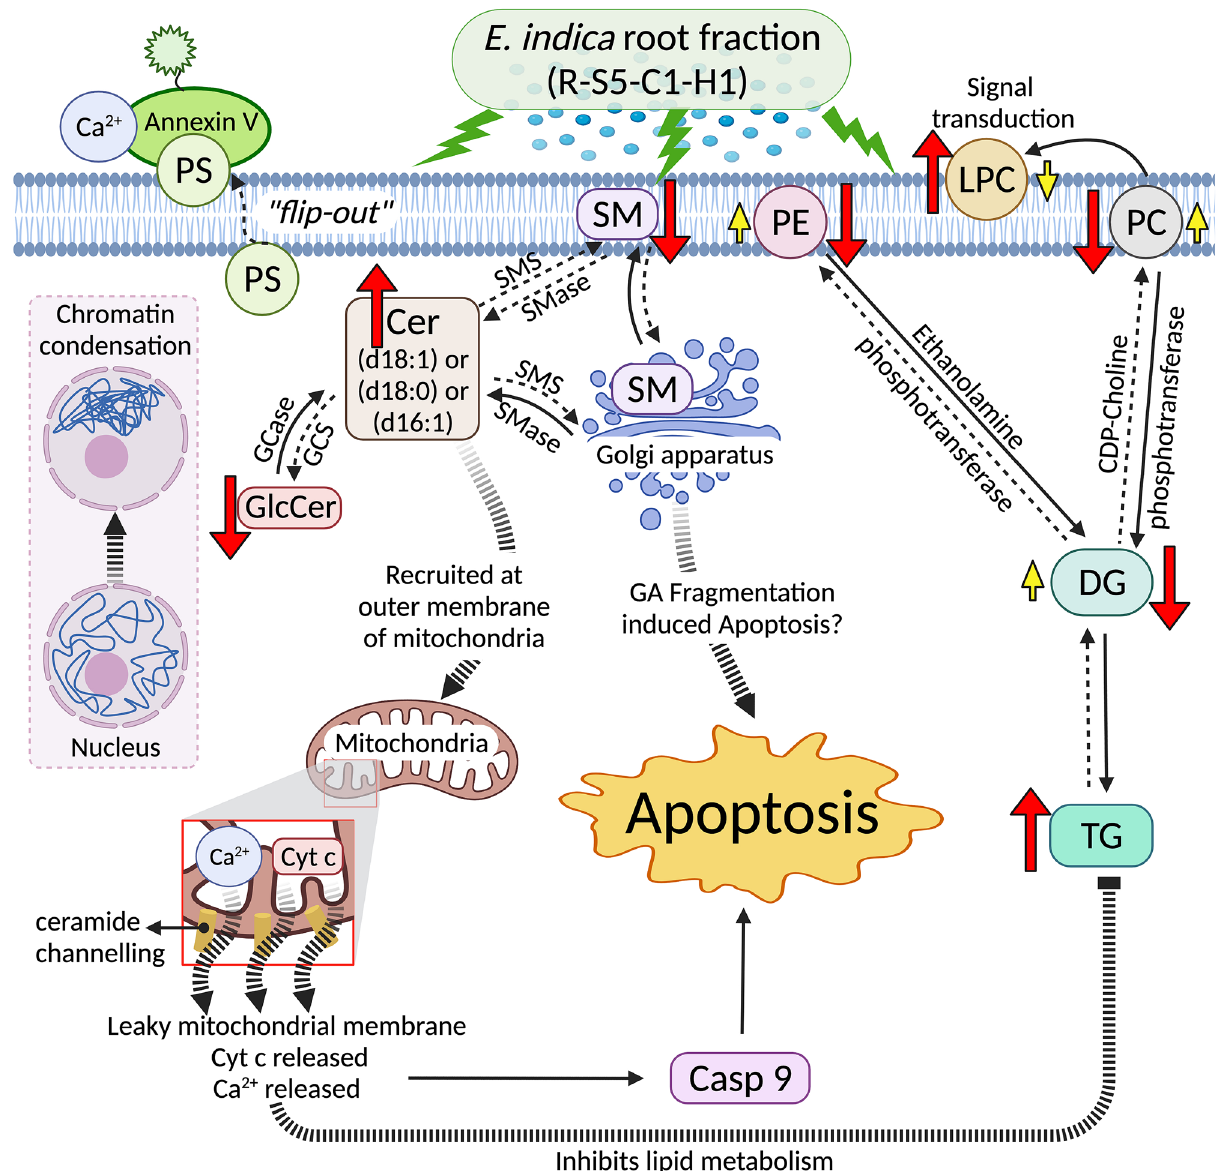
phosphatidylethanolamine, PS phosphatidylserine, TG triacylglyceride, DG diacylglyceride, Cer ceramide, GlcCer glucosylceramide. The figure was created with